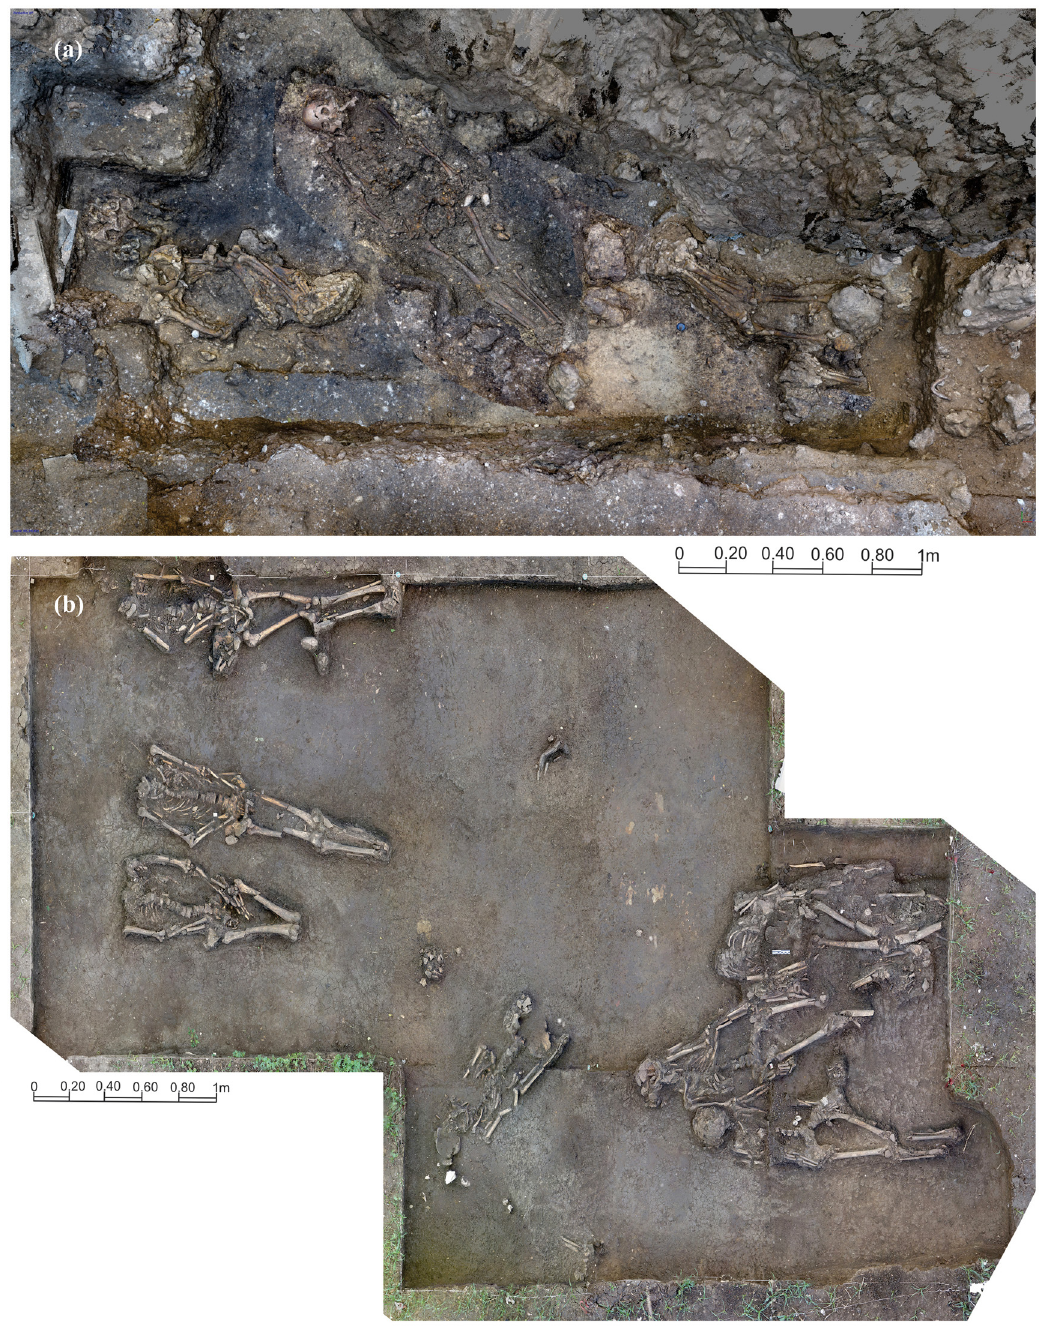
Figure 7: Orthophotos of excavation layers at Canímar Abajo ( a ) and Playa del Mango ( b )